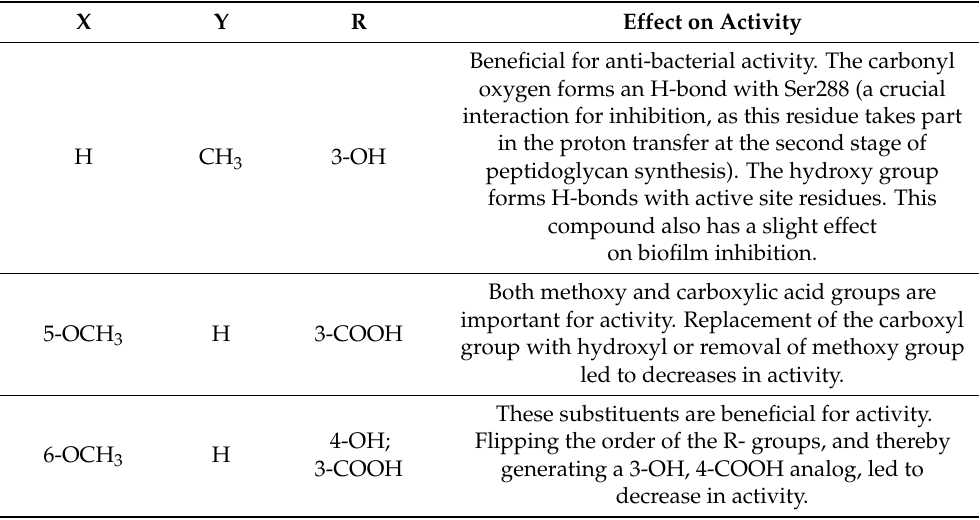
Table 2. Effect of substitutions of the most active derivatives of the 5-Indolylmethylen-4-oxo-2- thioxothiazolidine